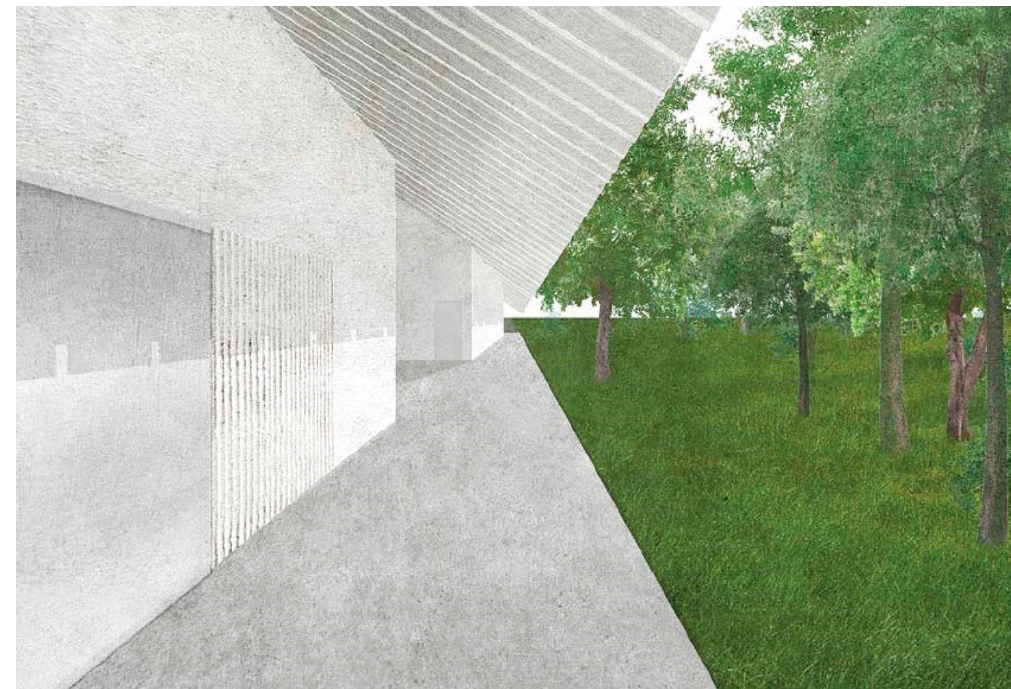
Figure 8. View along the main production unit.